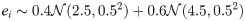
Average abundance of strategy A as a function of the payoff entry a0.Our simulation results clearly show that strategy A is more abundant than strategy B if a0 is approximately greater than 2.0 for regular networks (k = 2) (Panel (a)). This is in perfect agreement with our calculation based on the theorem, i.e., inequality a0 + 2a1 + a2 > b0 + 2b1 + b2 with a1 = 2, a2 = 1, b0 = 4, b1 = 1 and b2 = 1. Note that the criterion a0 > 2 is valid for aspiration across various distributions. It implies that the criterion to favor one strategy over the other is independent of the individualised aspiration, as stated in the theorem. Furthermore, the criterion also holds beyond regular networks (Panel (a)), namely, on random (Panel (b)) and scale-free networks (Panel (c)). It suggests that the criterion can be extrapolated to general population structures. The details of the simulations are as follows: The minimum degree of all the networks is set to be two such that all the individuals have enough neighbours to play the three-player game with. Personal aspirations are randomly assigned in a population with homogeneous aspiration ei = 2 for all i = 1, 2…N (blue ◯), and a population with heterogeneous aspirations generated based on uniform distribution on the interval [0, 5] (red □), bimodal distribution with ei∼0.4N(2.5,0.52)+0.6N(4.5,0.52) (orange ◊), and power-law distribution with probability density function f(x) = 2x−3 (purple △). Here, N(2.5,0.52) stands for the normal distribution with mean 2.5 and standard deviation 0.5. In addition, the minimum value of aspiration sampled from the power-law distribution is 1.0. In the beginning, we randomly set 45% of the population to be of strategy A and the rest to be of strategy B. At each time step, the focal individual randomly chooses two individuals from its neighborhood and play a single three-player game with them to obtain the payoff. Fermi function is employed as the decision making function for all the individuals. Each data point is the mean of the average abundance of strategy A calculated from three independent runs (5 × 109 samples in each run, 1.5 × 1010 samples in total). In each run, we start sampling after a relaxation time of 5 × 107 time steps. The average abundance of strategy A is obtained by averaging the abundance of strategy A over 5 × 109 time steps. The population size N = 1000. The selection intensity β = 0.005.